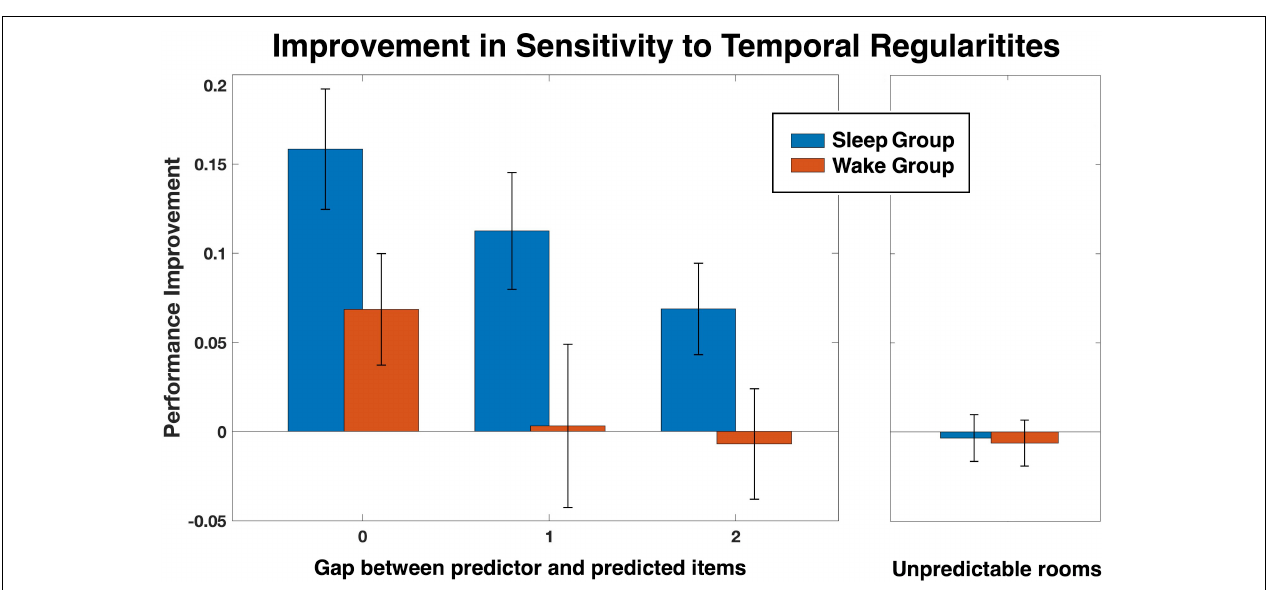
FIGURE 3 | Improvement in sensitivity to the hidden temporal regularities from quartile 2 to quartile 4 for each group as a function of the gap between the predictor and predicted items constituting those regularities. Results are presented alongside the performance for unpredictable rooms, for